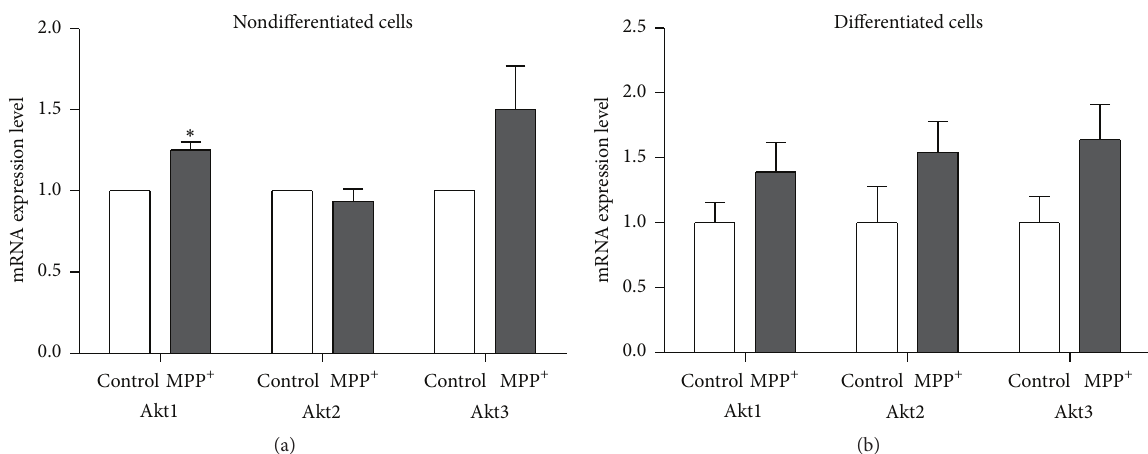
Figure 5: mRNA expression levels of Akt1 , Akt2 , and Akt3 in nondifferentiated SH-SY5Y cells (a) and mRNA expression levels of Akt1 , Akt2 , and Akt3 in differentiated SH-SY5Y cells (b). For neuronal differentiation, SH-SY5Y cells were treated with 10 𝜇 M retinoic acid for three days before exposure to MPP + . The control groups for nondifferentiated and differentiated SH-SY5Y cells were treated with the same medium without MPP + . Real-time quantitative PCRs were repeated three times in triplicate measurement. Data are expressed as relative to a control and shown as mean ± SEM. ∗ indicates 𝑃 < 0.05 versus control of each